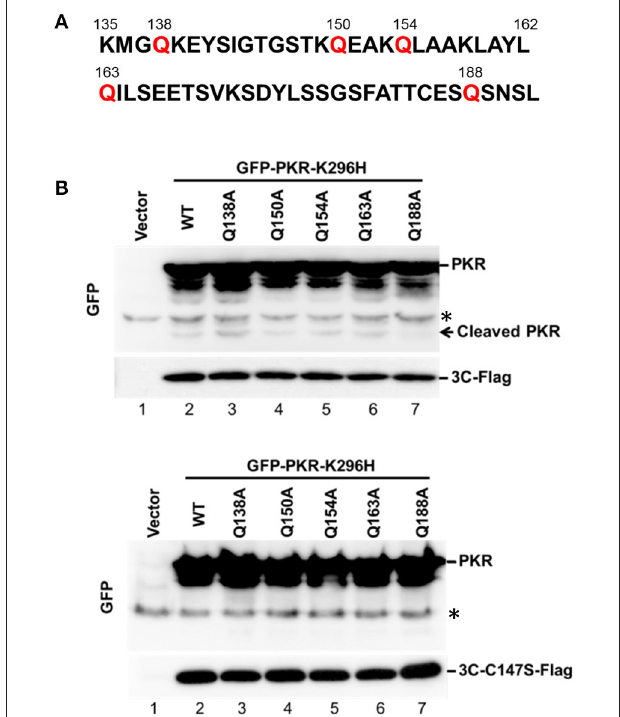
FIGURE 3 | The Q188–S189 pair is the site of PKR cleavage. (A) Primary sequences of amino acids 135–192 within PKR. In this region, glutamine residues at sites 138, 150, 154, 163, and 188 were replaced with alanine residues by site-directed mutagenesis. (B) The potential 3C cleavage site in PKR. The 293T cells were cotransfected either with plasmids encoding the 3C and GFP-PKR variants (upper panel), or plasmids encoding the 3C mutant C147S and GFP-PKR variants (lower panel). At 24 h after transfection, the cell lysates were subjected to western blot analysis using antibodies against GFP and Flag. A representative result from at least three reproducible experiments is shown. *Denotes non-specific